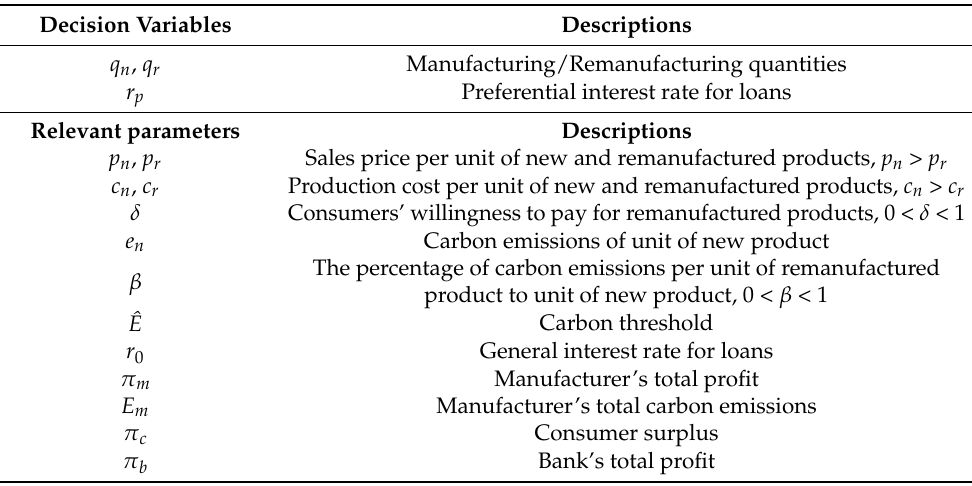
Table 1. Notations for decision variables and